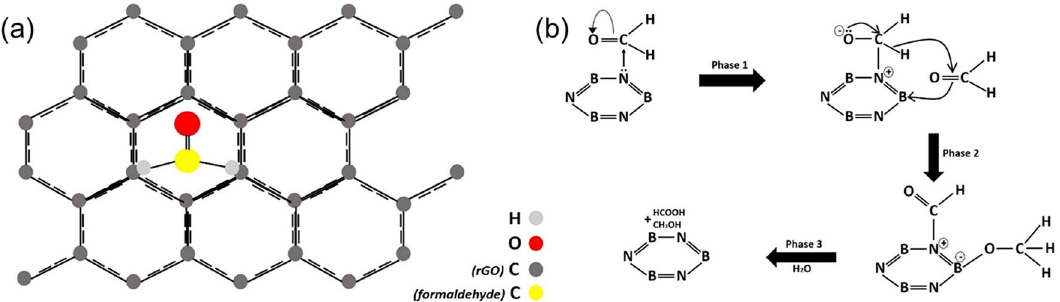
Figure 7. ( a ) Adsorption configuration of formaldehyde on reduced graphene oxide (rGO) sheet. ( b ) Possible disproportionation reaction for formaldehyde over the surface of porous boron